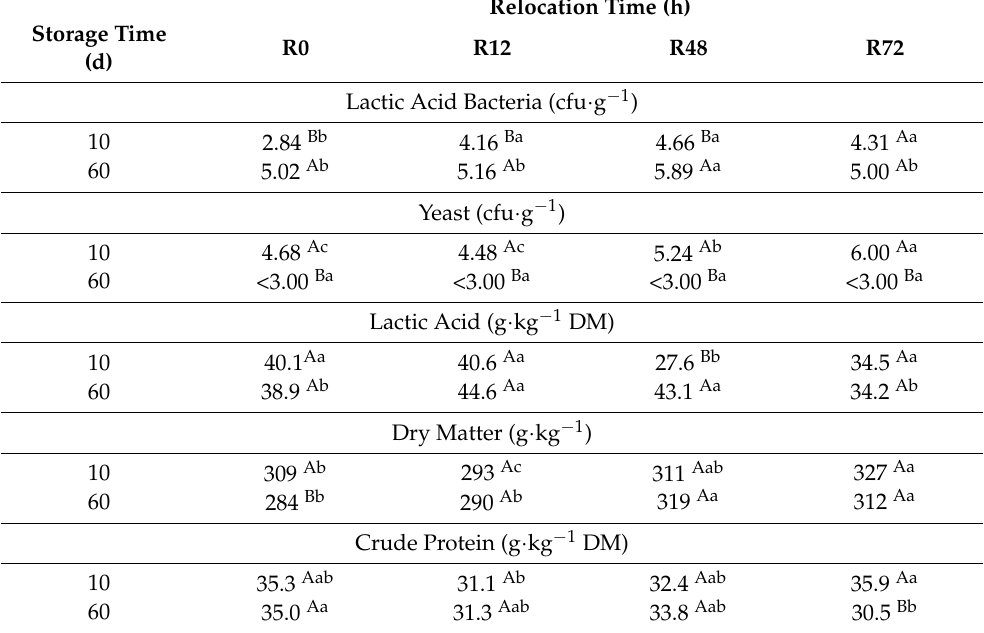
Relocation Time (h)